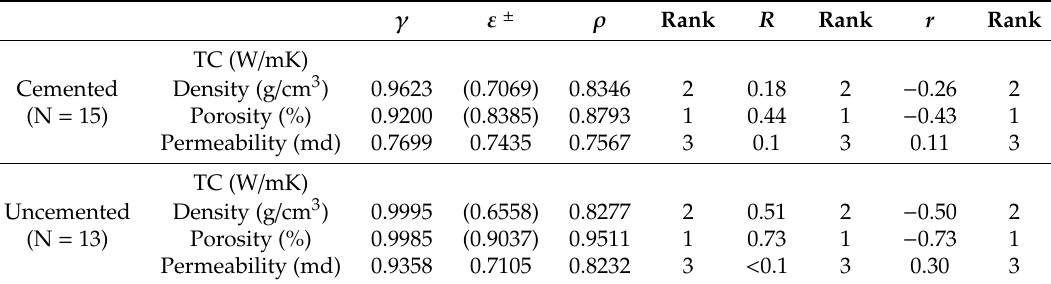
Table 3. Relationships between TC and three